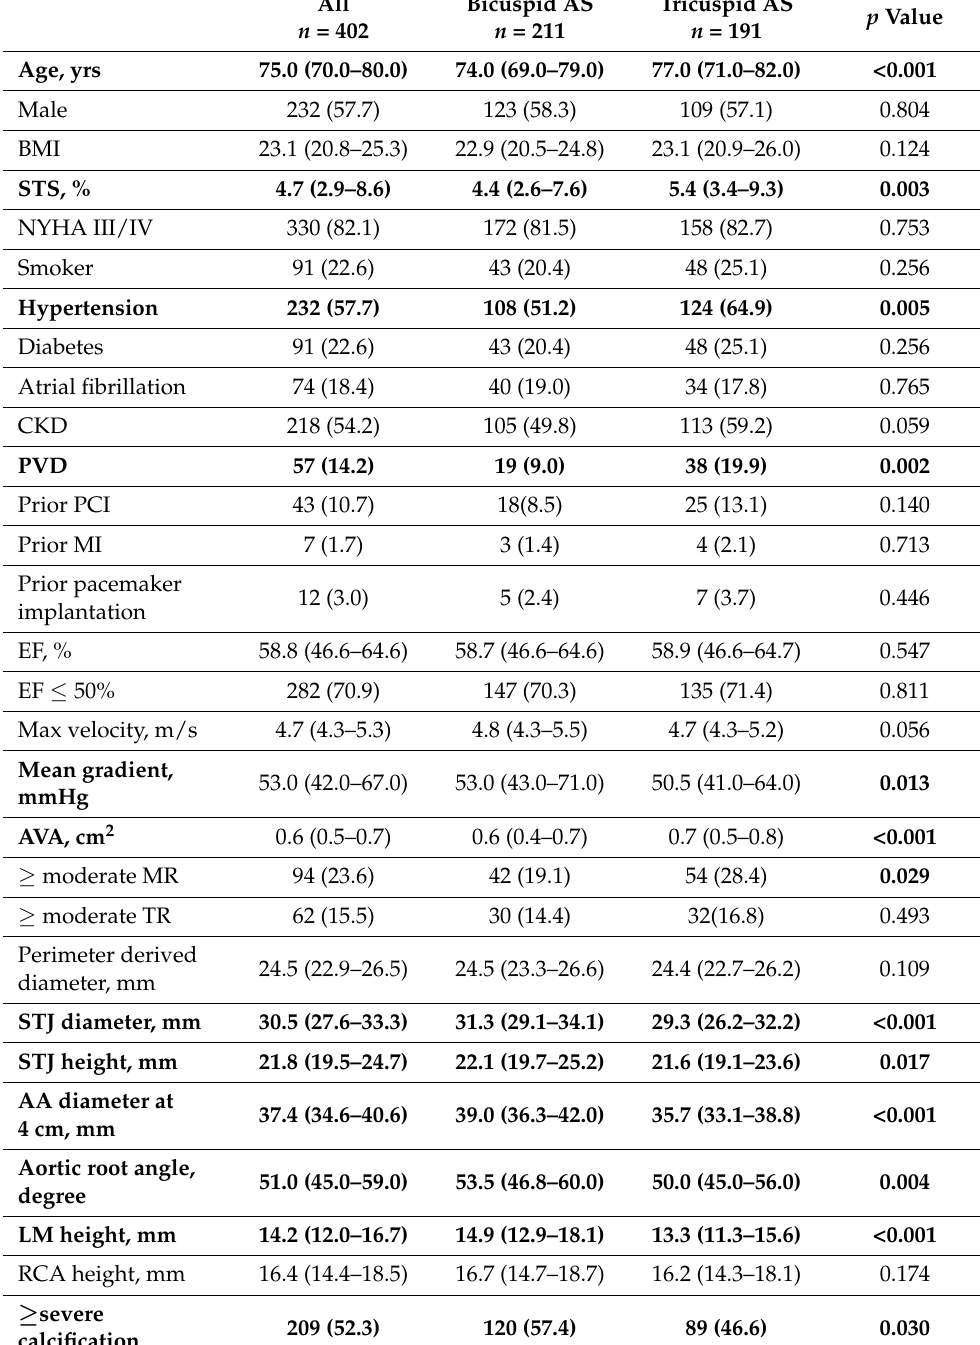
Table 1. Baseline Characteristics of Bicuspid AS and Tricuspid AS